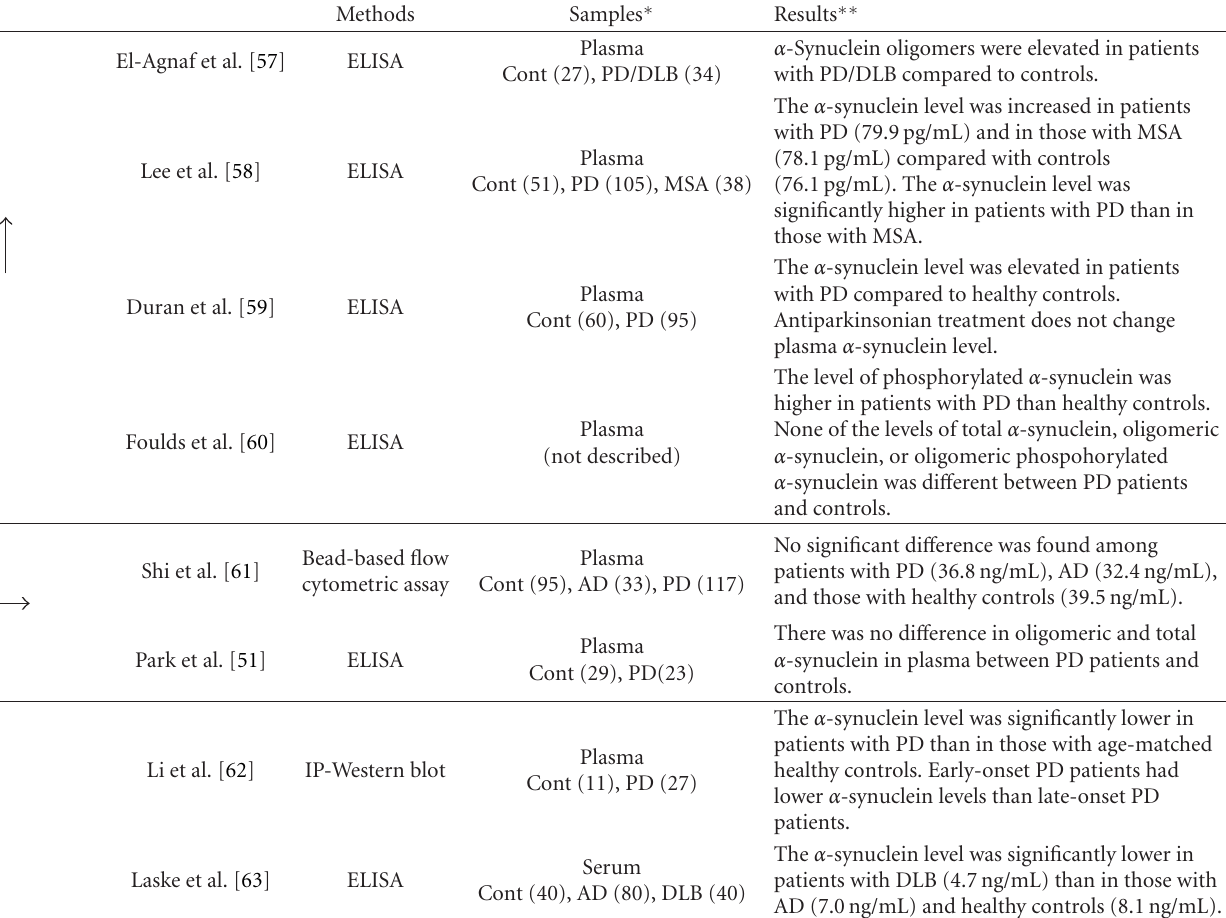
Table 3: Studies of quantification of α -synuclein level in blood of patients with DLB and other